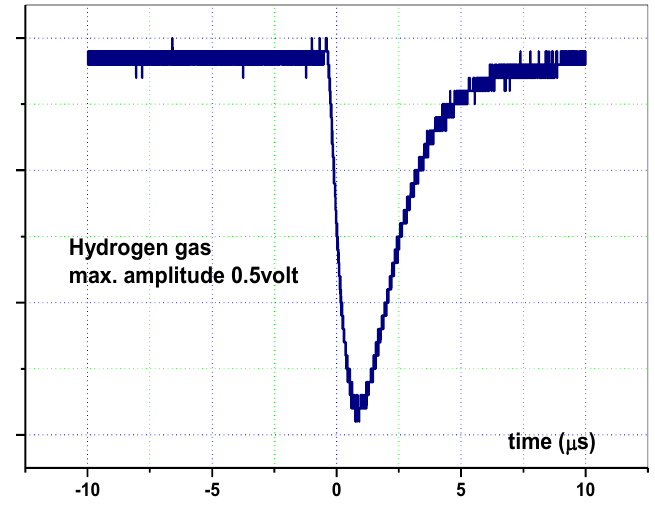
Figure 7. Temporal evolution of hard X-ray